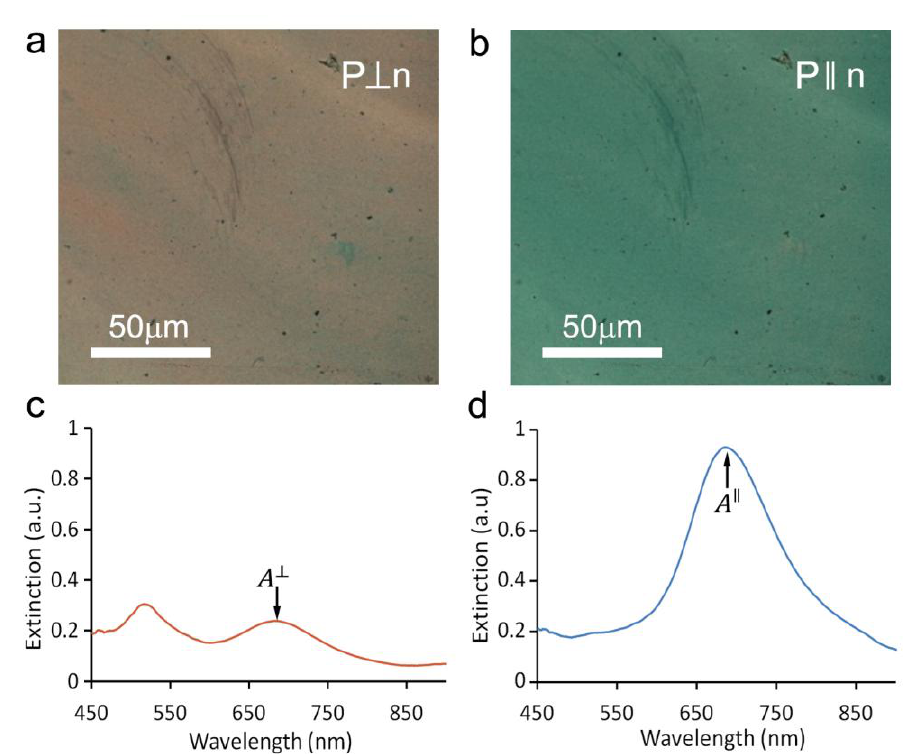
Figure 1. Cellulose films decorated with Gold nanorods (GNRs) produced by use of shear alignment of Cellulose nanocrystal (CNC)-GNR co-dispersions. ( a,b ) Bright field polarized microscopy images with analyzer aligned perpendicular ( a ) and parallel ( b ) to the director n show that nanorods are generally aligned along n , with absorption due to the transverse and longitudinal SPRs yielding pink and blue colors, respectively. ( c,d ) The extinction spectra of a thin dried film of CNCs and GNRs for linear polarizations perpendicular ( c ) and parallel ( d ) to n , confirming that the transverse and longitudinal SPRs with peaks at 525 nm and 680 nm, respectively, are significantly stronger in the perpendicular and parallel orientations,